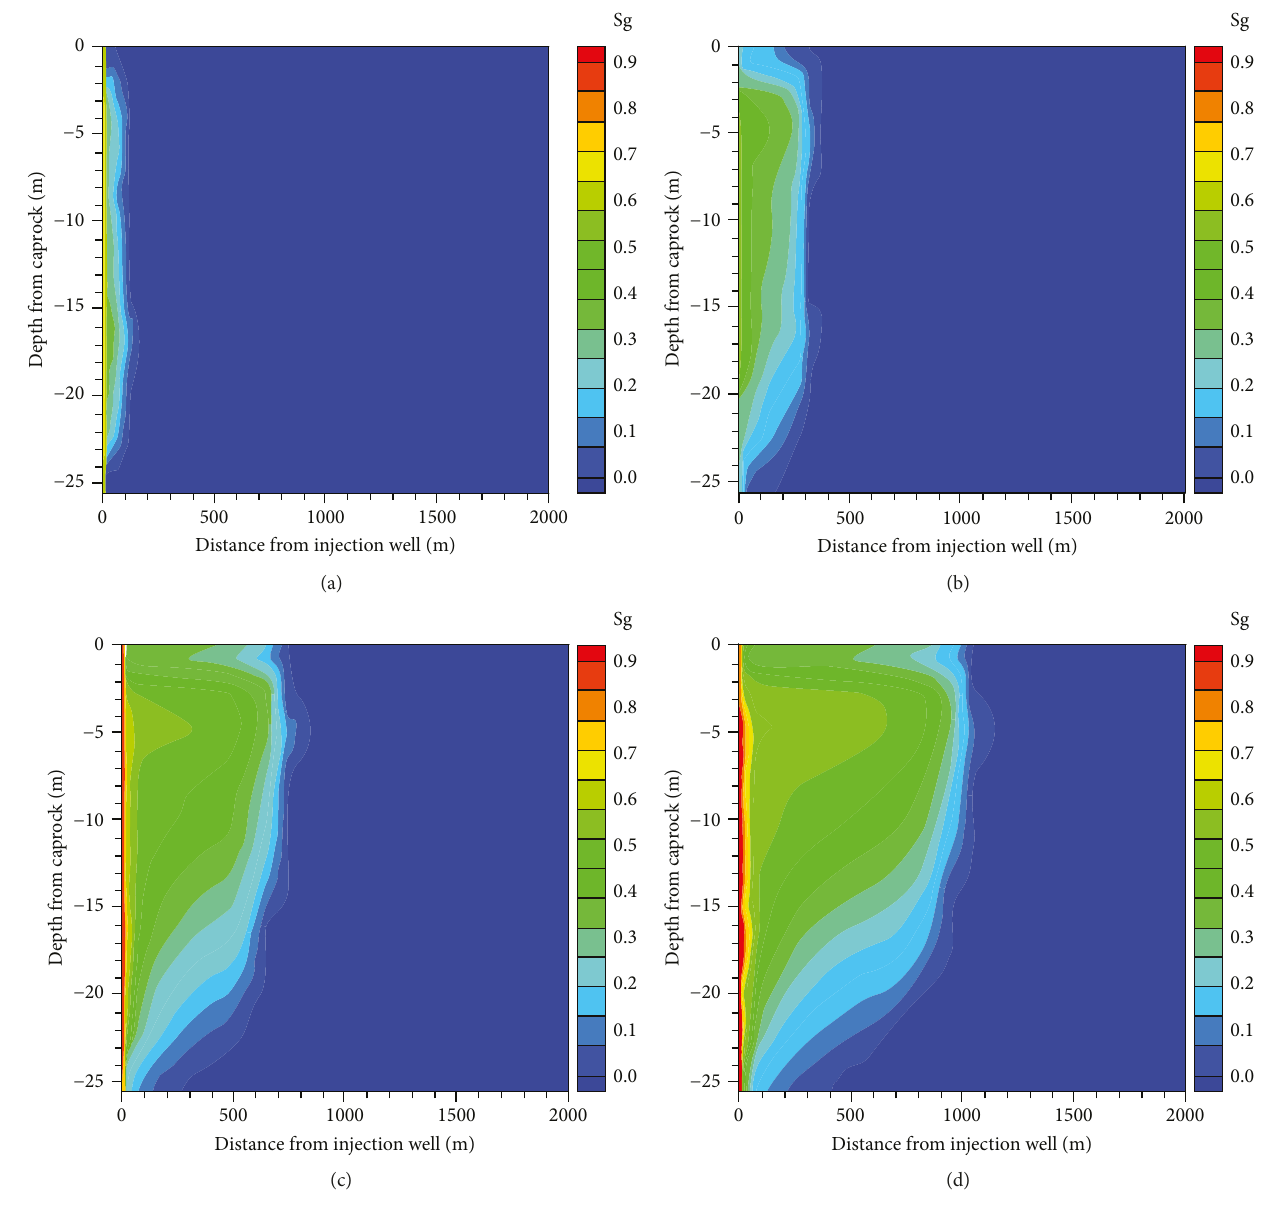
during injection (Sg: gas saturation of CO 2